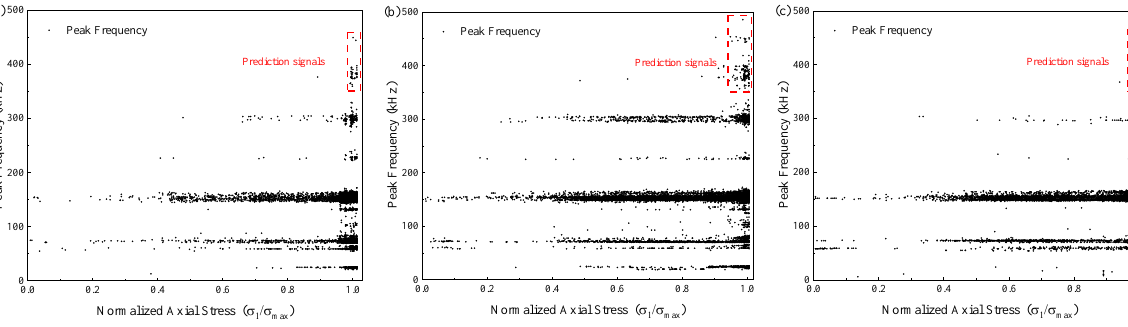
Appl. Sci. 2021 , 11 , x FOR PEER REVIEW Figure 7. Relationship between peak frequency distribution and normalized axial stress. ( a ) A1, ( b ) B1, ( c ) C1. Figure 7. Relationship between peak frequency distribution and normalized axial stress. ( a ) A1, ( b ) B1, ( c ) C1. Figure 7. Relationship between peak frequency distribution and normalized axial stress. ( a ) A1, ( b ) B1, ( c ) C1.